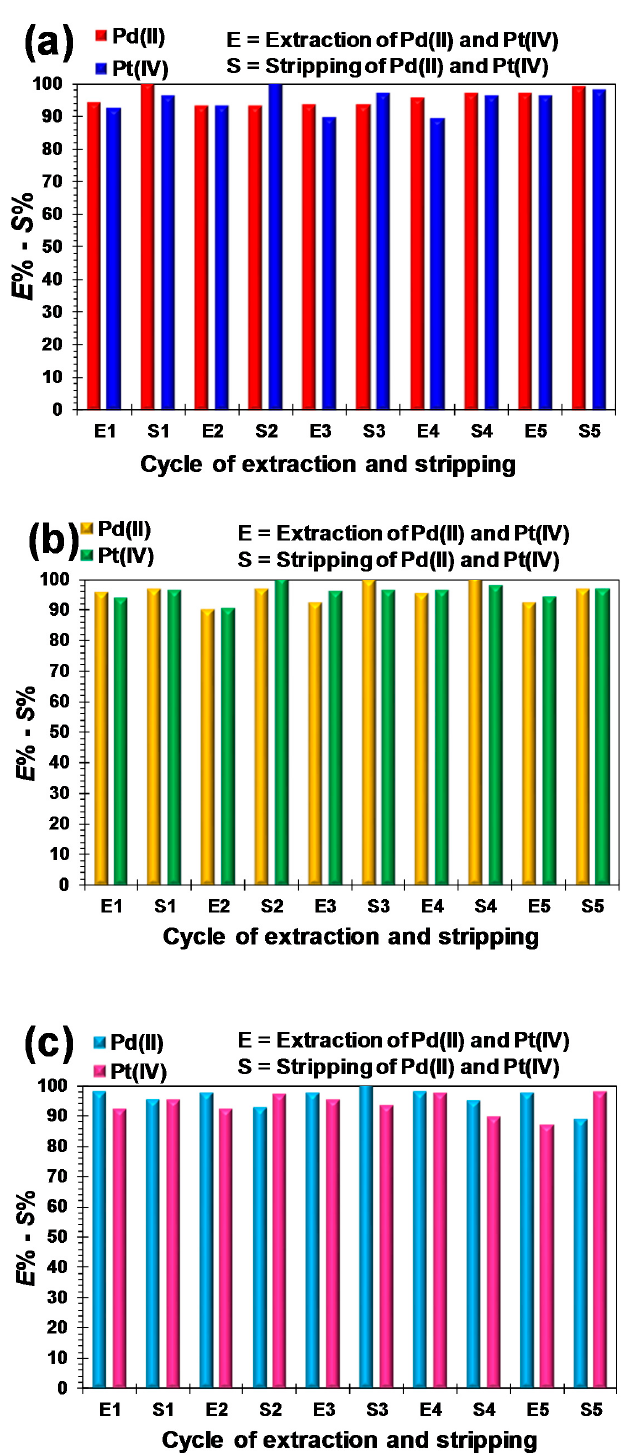
Figure 3. E % and S % in extraction and stripping cycles of extractants ( a ) 3 , ( b ) 4 , and ( c ) 5 . Condition: contact time = 60 min for extraction and stripping; shaking speed = 300 rpm for extraction and stripping; organic phase: [ 3 – 5 ] = 10 mM in chloroform, aqueous phase: the leach liquors of automotive catalysts, stripping reagent = 0.1 M thiourea/1.0 M HCl, A/O = 1 (10 mL × 10 mL) for extraction and stripping, A/O = 2 (20 mL × 10 mL) for washing with water; temperature = 20 ± 1 °C.